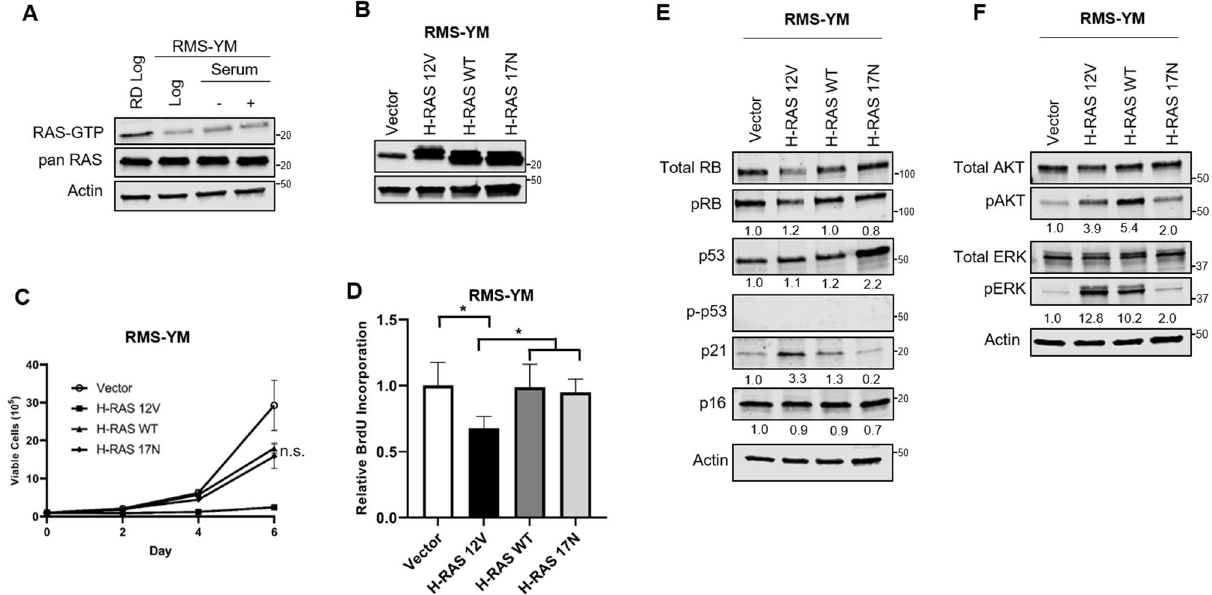
Figure 6. Stable expression of oncogenic H-RAS 12V inhibits growth and decreases proliferation in RAS wild type eRMS cells. ( A ) Under log phase growth conditions, the RAS WT eRMS cell line, RMS-YM, displayed lower levels of RAS-GTP than the N-RAS mutant RD cell line. Under serum stimulation conditions, RAS-GTP levels were still lower in RMS-YM cells than RD cells. Cells were collected either in log phase, after 48 h of serum starvation, or 48 h of serum starvation followed by 1 h of growth in serum media. RD cells collected in log phase were included as a positive control. ( B ) Immunoblot confirmation of ectopic expression of H-RAS 12V, H-RAS WT, or H-RAS 17N in RMS-YM cells. ( C ) Expression of oncogenic H-RAS caused growth suppression in RMS-YM cells. Wild type and dominant negative H-RAS also impaired growth in RMS-YM cells, though not to the same degree as oncogenic H-RAS, and did not meet statistical significance. ( D ) RMS-YM cell proliferation decreased in response to expression of oncogenic H-RAS, as measured by BrdU assay. ( E ) Whereas H-RAS 12V and H-RAS WT drove upregulation of p16 in Rh28 and RD cells with modest increase in p21 in Rh28, RMS-YM cells showed upregulation of p21 with no change to p16. Expression of dominant negative H-RAS led to a two-fold increase of p53. ( F ) Expression of H-RAS 12V and H-RAS WT constructs increased AKT and ERK activation as assessed by levels of pAKT and pERK. Actin used as a loading control. (*p < 0.05; **p < 0.01; ****p <